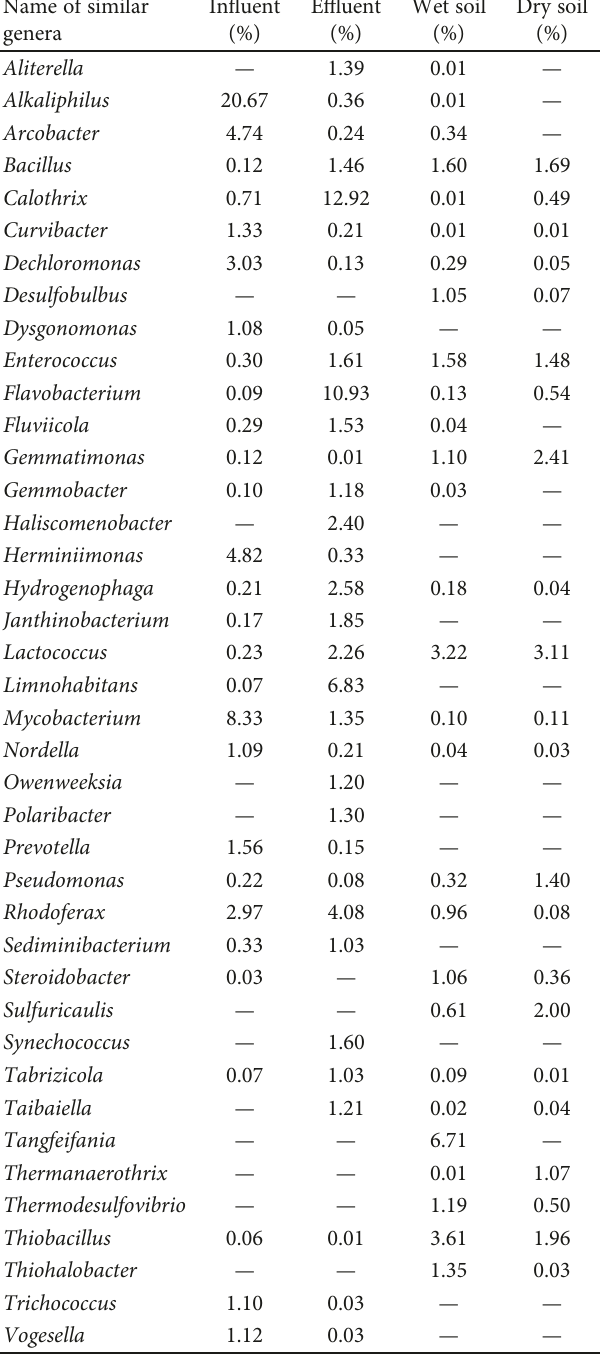
Table 3: The bacterial dominant genera in four samples in constructed